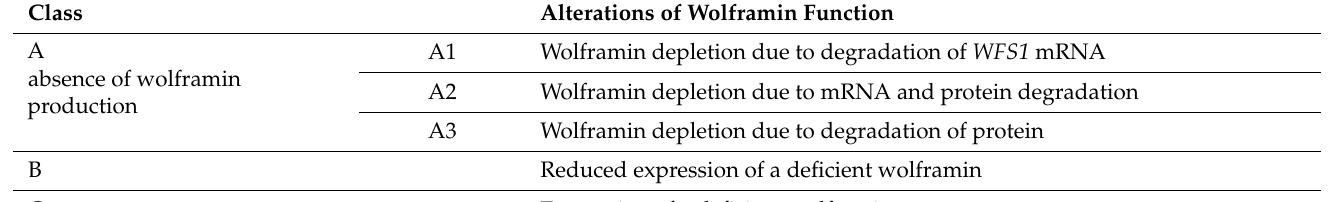
Table 1. Functional alterations of wolframin according to type of WFS1 mutations.